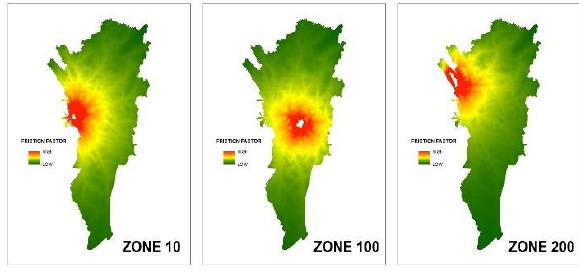
Figure 8. Sample Friction Factor Raster Files